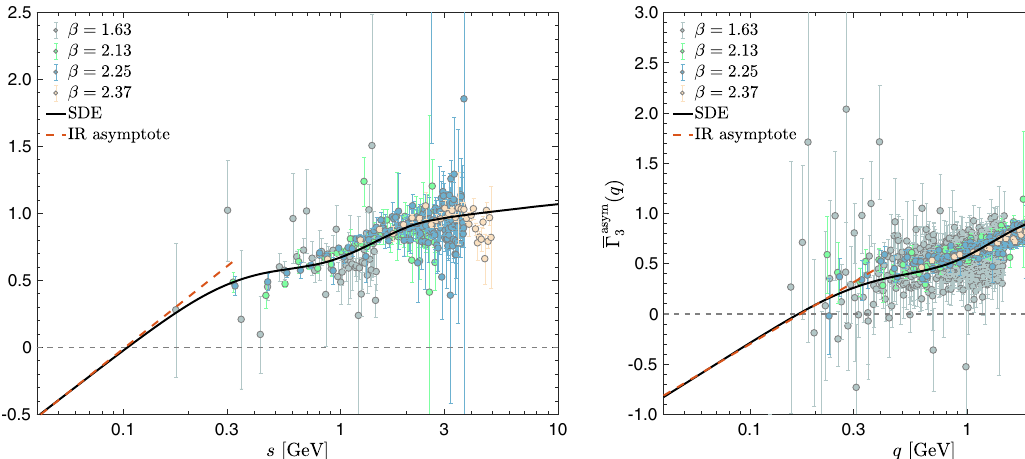
(black continuous curve). Right panel: The same for the asymmetric form factor (cid:2) asym 3 ( q ) . The IR asymptotes (red dashed lines) are given by Eqs. (4.4) and (4.5),